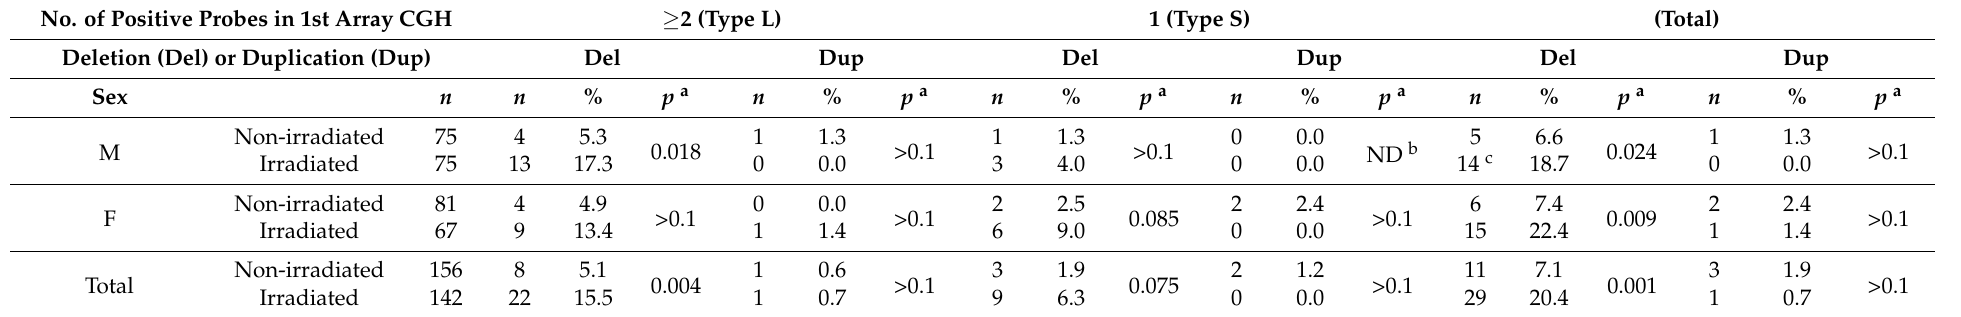
Table 3. List of the F1 mice bearing 4 or more confirmed de novo CNVs, with the number of the (candidate) CNVs detected by array CGH, analyzed by qPCR, and confirmed by qPCR. No. of Positive Probes in 1st Array CGH ≥ 2 (Type L) 1 (Type S) (Total) No. of Positive Probes in 2nd Array CGH ≥ 5 4 3 2 (Total) Deletion (Del) or Duplication (Dup) Del Dup Del Dup Del Dup Del Dup Del Dup Del Dup Del Dup Detected by array CGH 0 0 0 0 1 0 5 0 13 0 19 0 19 0 0mGyJ4 (F) Analyzed by qPCR 0 0 0 0 1 0 5 0 1 0 7 0 7 0 Confirmed by qPCR 0 0 0 0 0 0 3 0 1 0 4 0 4 0 Non-irradiated Detected by array CGH 0 0 0 0 3 0 9 0 43 0 55 0 55 0 0mGyX5 (F) Analyzed by qPCR 0 0 0 0 3 0 2 0 5 0 10 0 10 0 Confirmed by qPCR 0 0 0 0 2 0 2 0 1 0 5 0 5 0 Detected by array CGH 0 0 14 0 18 0 27 0 49 0 108 0 108 0 20mGyA2 (M) Analyzed by qPCR 0 0 3 0 3 0 5 0 11 0 22 0 22 0 Confirmed by qPCR 0 0 3 0 1 0 1 0 6 0 11 0 11 0 Detected by array CGH 0 0 1 0 2 0 3 0 10 0 16 0 16 0 Irradiated 20mGyF5 (F) Analyzed by qPCR 0 0 1 0 0 0 0 0 Confirmed by qPCR